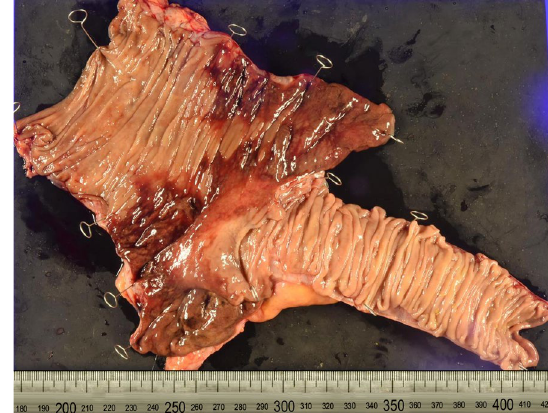
Fig. 3 Necrosis and bleeding of the mucosa are observed predominantly in the contralateral mesentery in the ileocecal